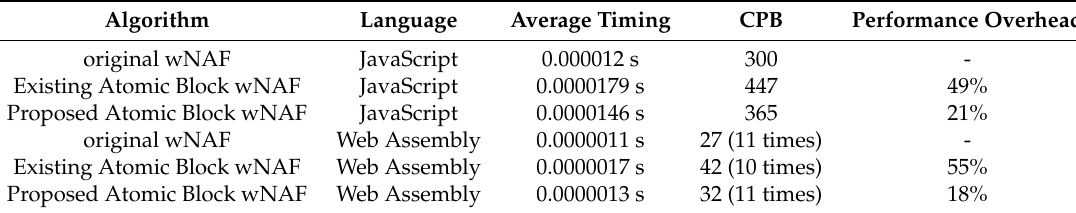
Table 13. wNAF algorithm performance in Chrome ( CPB : Cycle Per Byte), ( w = 4).